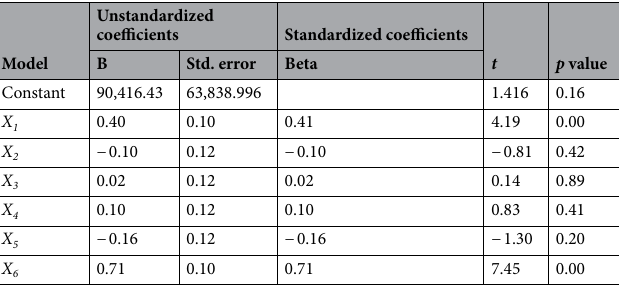
Table 4. The parameters of MLR model.